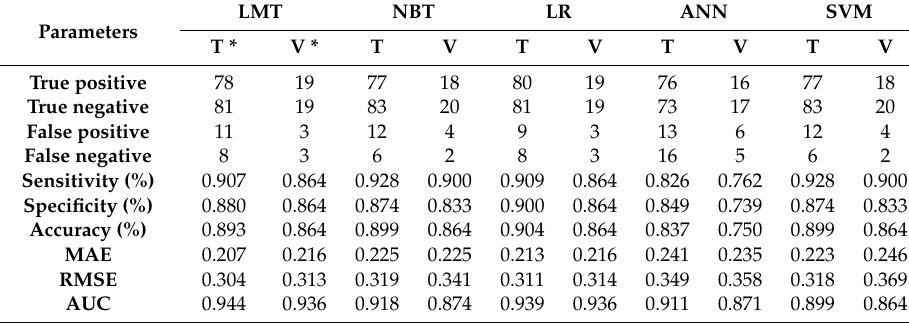
Model performances of the applied data-mining approaches for the training and validation